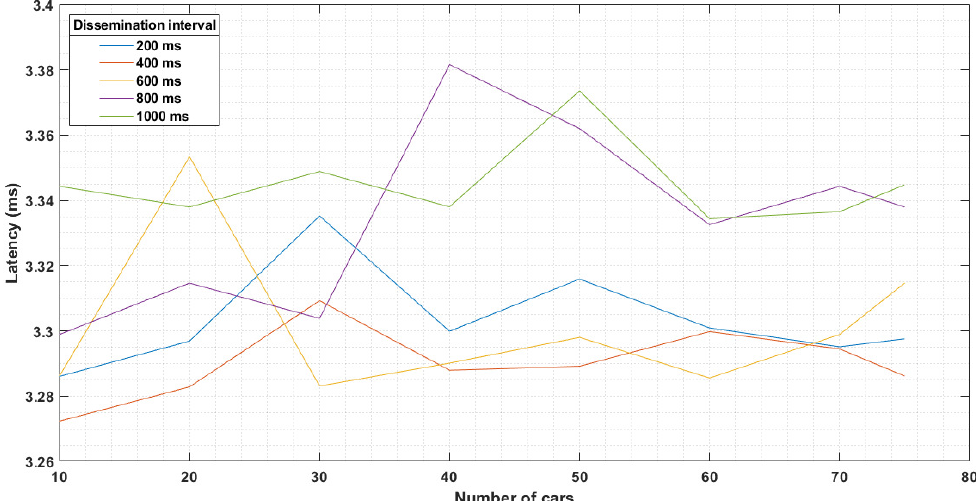
Figure 15. Inter-layer time